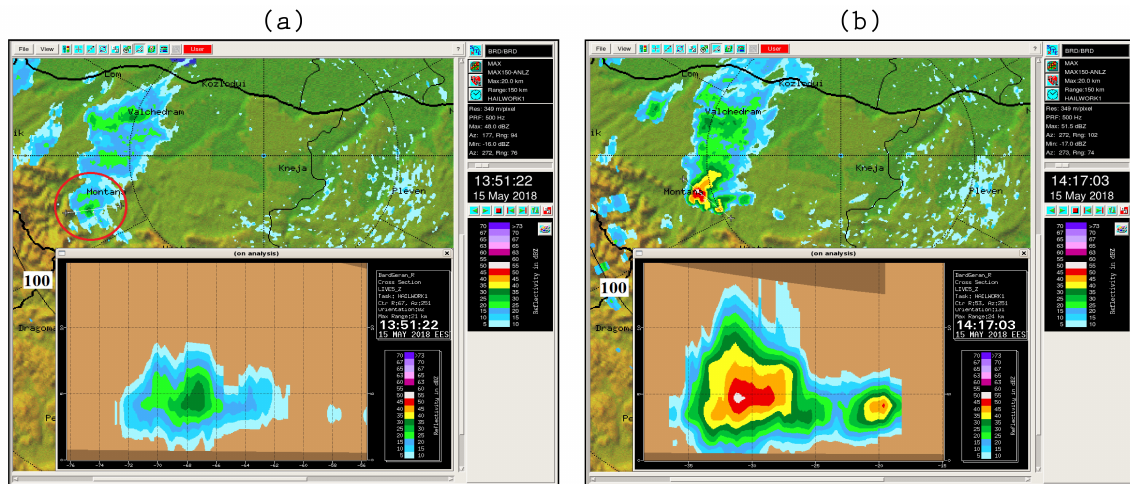
Figure 3. Initial evolution of the supercell at ( a ) 10:51 UTC (the cell on the map is shown by a red circle) and ( b ) 11:17 UTC when a daughter cell developed on the eastern side of the main cell. Note that the times in the two figures are local (UTC + 3 h).